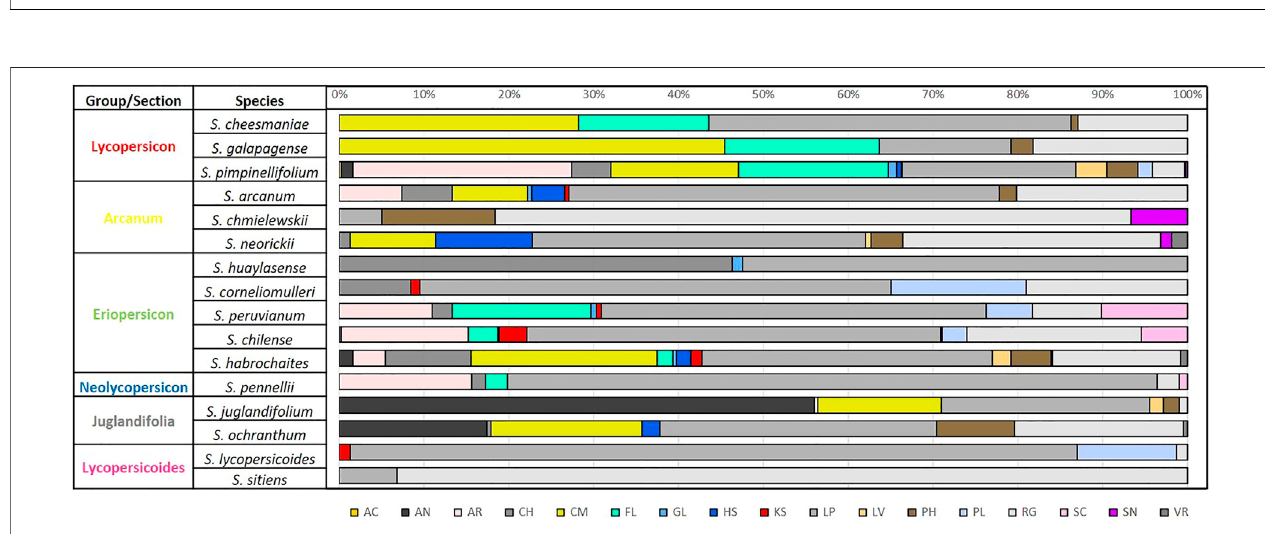
FIGURE 7 | Percentage of soil type by species according to FAO/IIASA/ISRIC/ISSCAS and JRC (2009), for 12 wild tomato ( Solanum sect. Lycopersicon) and 4 closely related species ( Solanum sect. Juglandifolia and sect. Lycopersicoides). Soil type: AC (acrisol), AN (andosol), AR (arenosol), CH (chernozem), CM (cambisol), FL ( fl uvisol), GL (gleysol), HS (histosol), KS (kastanozem), LP (leptosol), LV (luvisol), PH (phaezem), PL (planosol), RG (regosol), SC (solonchak), SN (solonetz), and VR (vertisol).